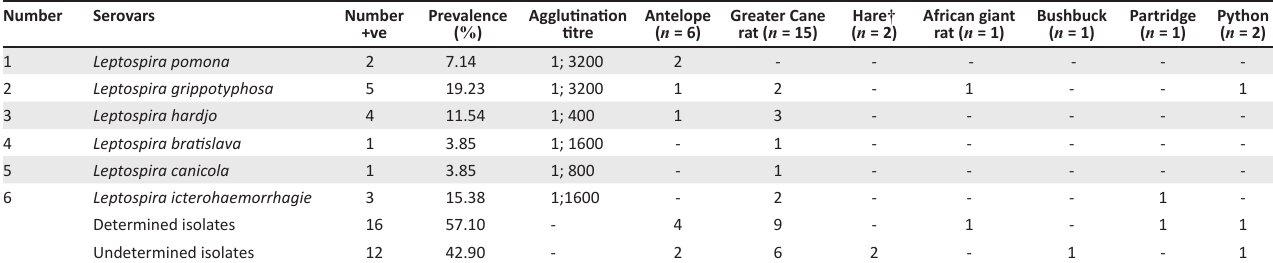
TABLE 3: Prevalence and characterisation of 28 Leptospira isolates of wild animals using monoclonal antibodies in the microscopic agglutination test.